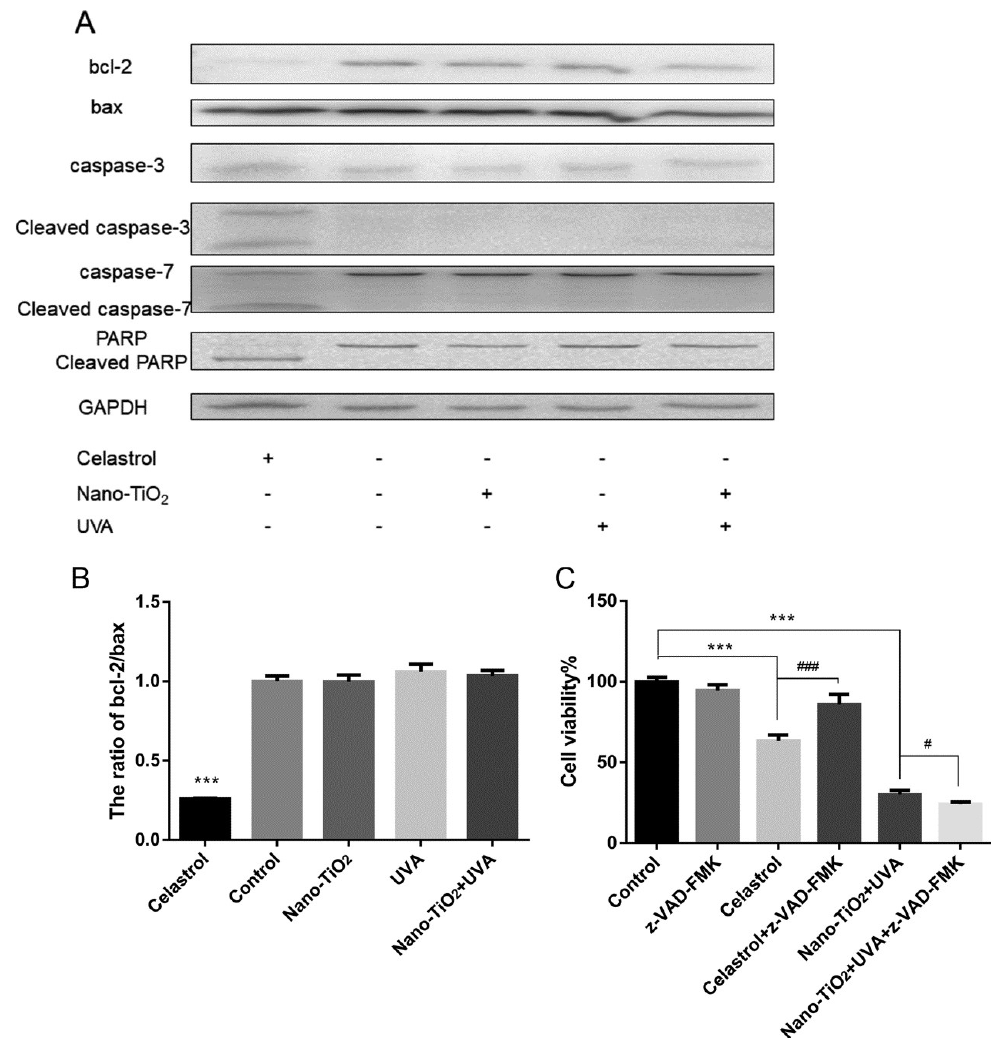
Figure 2. Caspase-dependent cell apoptosis was not activated in HeLa cells treated with nano-TiO